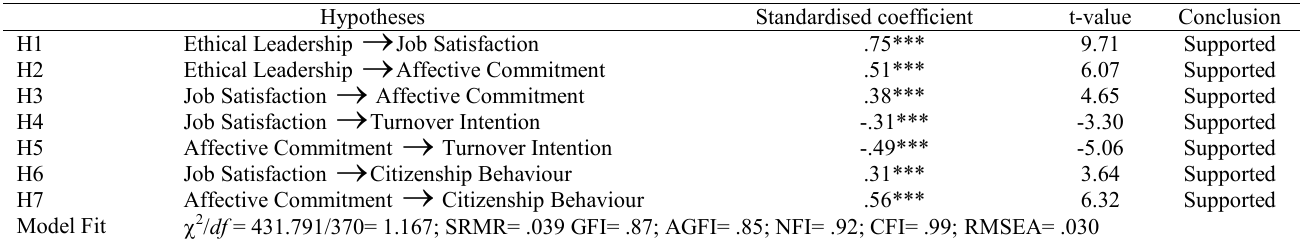
Table 4: SEM paths results for the proposed